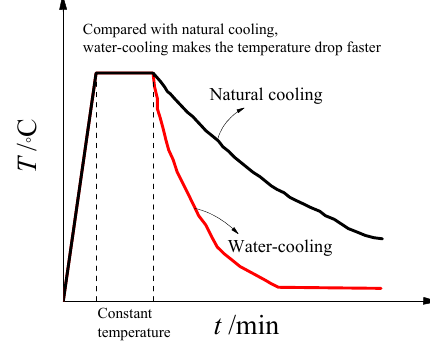
Figure 2. Schematic diagram of heating.